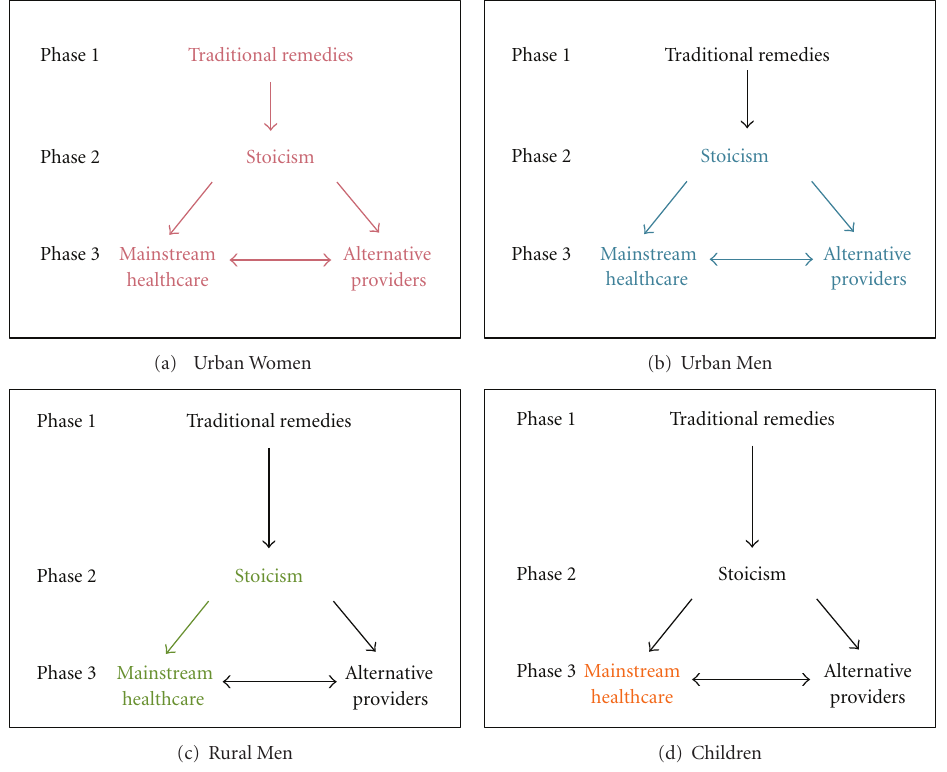
Figure 1: Process of seeking healthcare among focus group participants (Latino immigrants). “Phase” represents the strategy summarizing the healthcare-seeking behavior expressed by the participants. Arrows represent the change in strategy. The process applicable (colored font and arrow) and not applicable (gray font and arrow) to each population of participants is represented. (a) urban women, (b) urban men, (c) rural men, and (d)